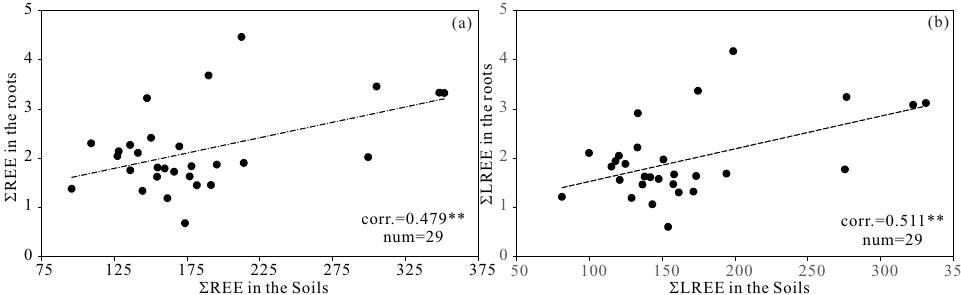
Figure 8. Scatter diagram of ( a ) Σ REE in the rhizosphere soils versus roots and ( b ) Σ LREE in the rhizosphere soils versus roots. ** p < 0.01.